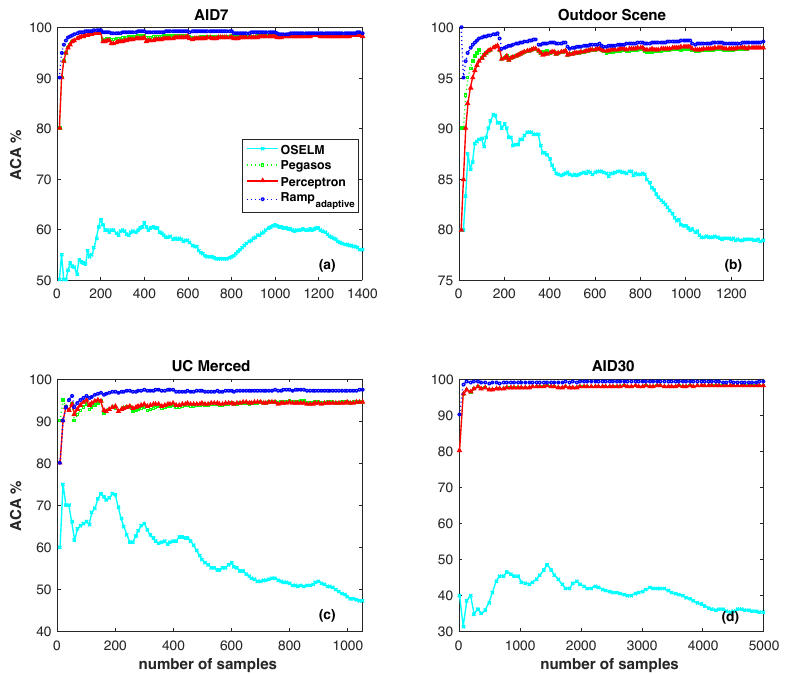
Figure 9. Average classification accuracy for different algorithms on ( a ) AID7; ( b ) Outdoor Scene; ( c ) UC Merced and ( d ) AID30 as a function of the number of learning